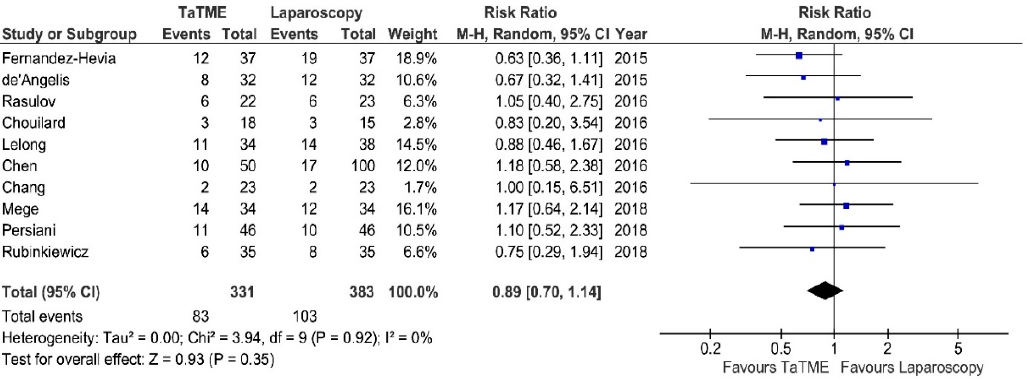
Figure 2. Overall morbidity. CI—Confidence Interval; df—degrees of freedom, M-H—Mantel-Haenszel test. WMD and RR are presented on the graphs as squares, and overall WMD and RR is presented as diamond.